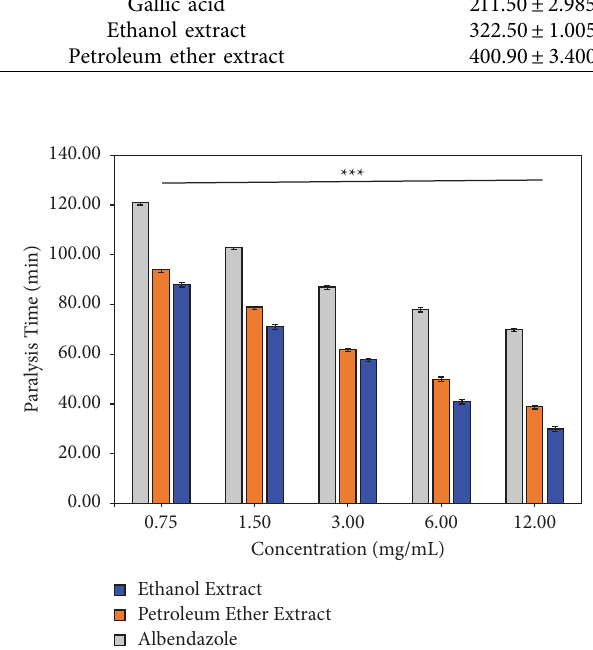
Figure 5: Anthelmintic activity of the extracts of C. nioroense and albendazole (for paralysis) [1].